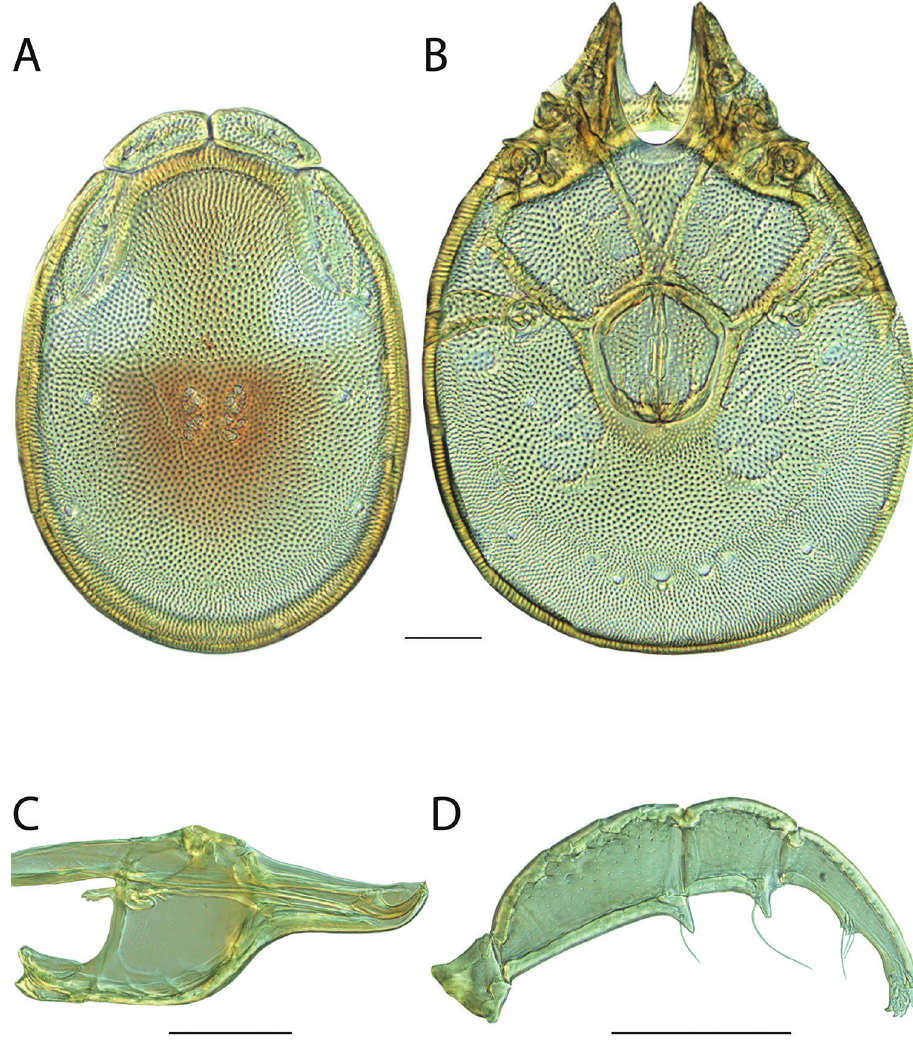
Figure 274. Torrenticola welbourni sp. n. female: A dorsal plates B venter (legs removed) C subcapitulum D pedipalp (setae not accurately depicted). Scale = 100